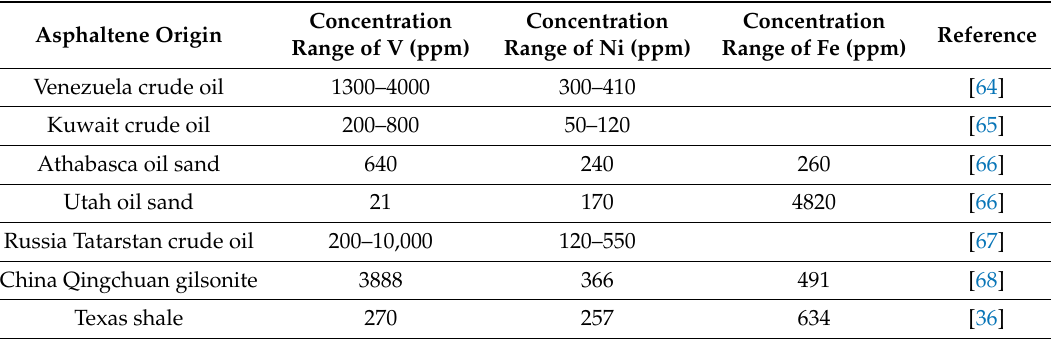
Table 2. Concentrations of V, Ni, and Fe in asphaltenes with di ff erent